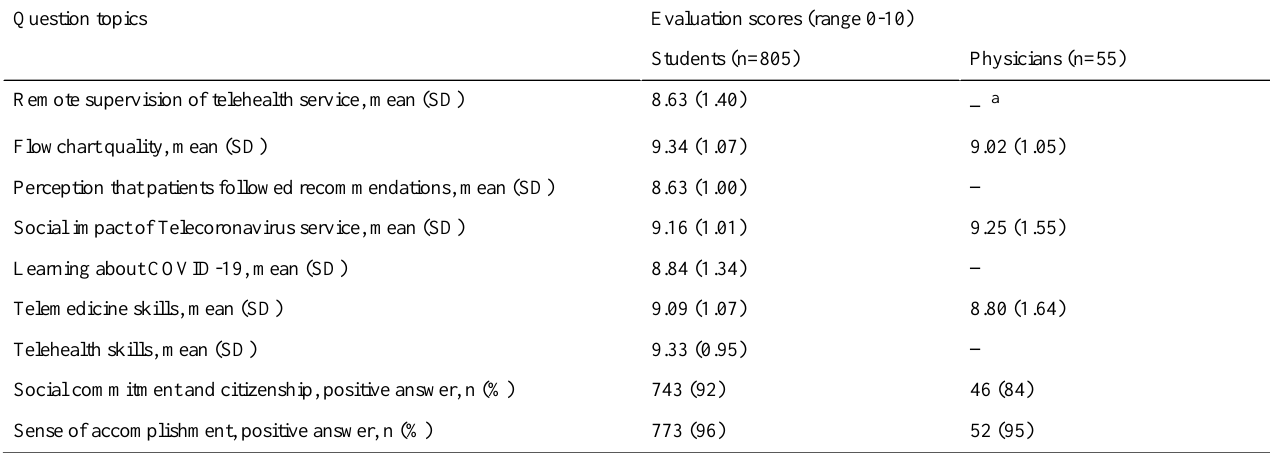
Table 1. Evaluations from physician and student volunteers regarding the development of telemedicine- or telehealth-related skills while using the Telecoronavirus program (Bahia,